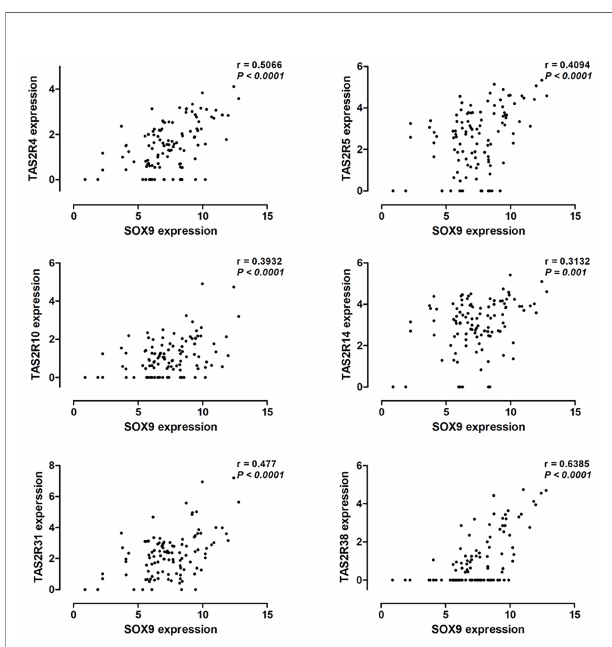
FIGURE 4 | Pearson correlation analysis to explore the correlation between SOX9 expression and the expression of the TAS2R family